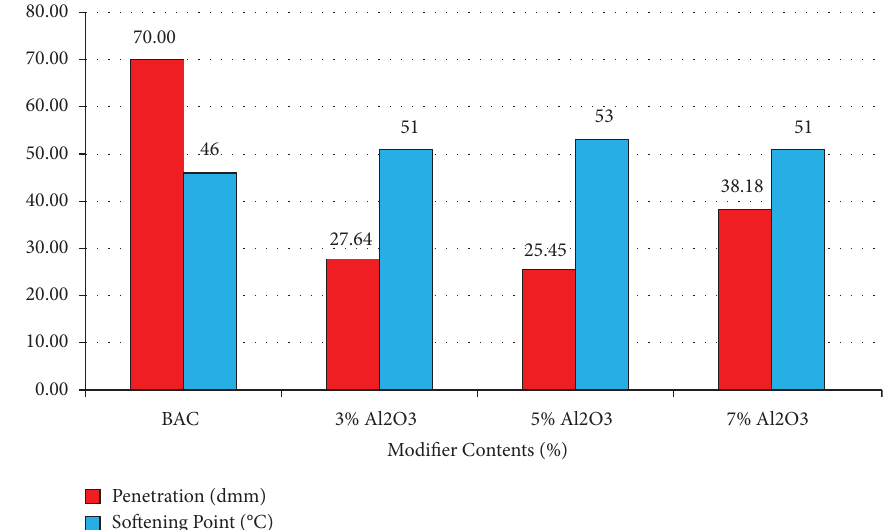
Figure 2: Infuences of nanoparticles on the penetration and softening points of modifed asphalt binders.